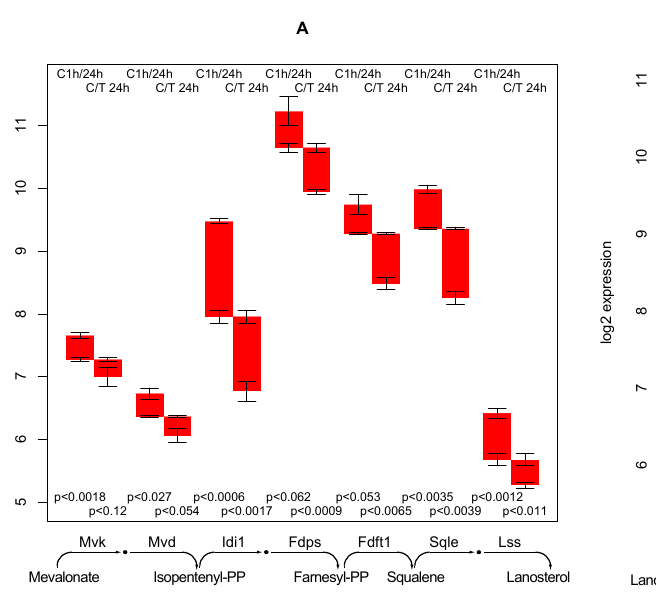
Figure 5 . Regulation of genes involved in cholesterol